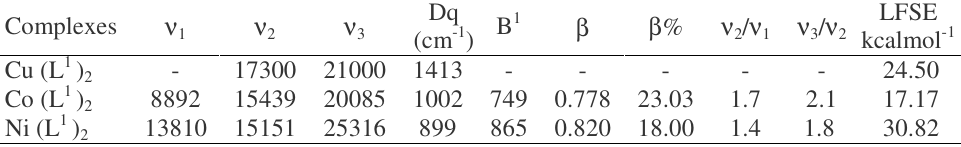
Table 2. Electronic spectral data and ligand field parameters of Cu(II), Co(II) and Ni(II) complexes